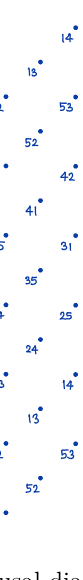
Figure 4 . Causal diamond for n = 5